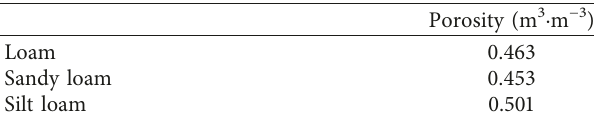
Table 2: Green-Ampt infiltration parameters for various soil